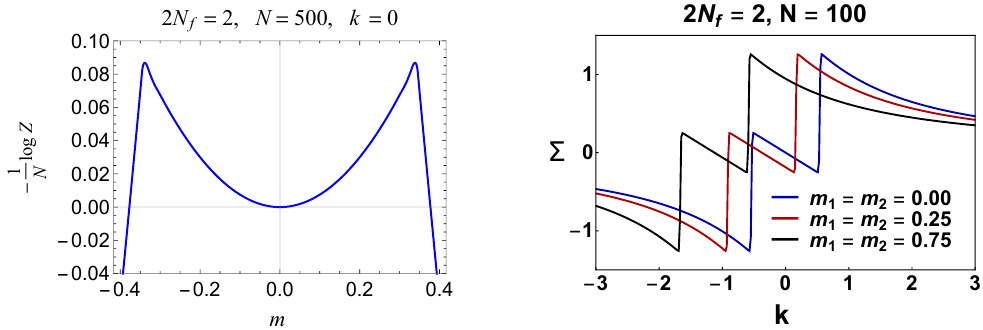
Figure 3 . The mass dependence of the free energy for k = 0 for two (cid:13)avors with mass ( m 1 ; m 2 ) = ( m; m ) (left) and the k dependence of the chiral condensate, (cid:6), for three di(cid:11)erent values of the mass also for two (cid:13)avors with equal